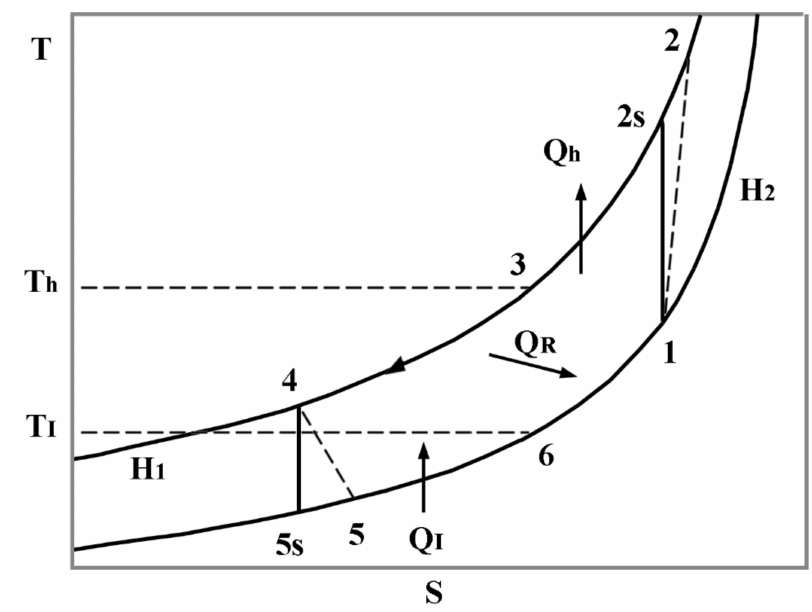
Figure 3. Brayton magnetic cycle with regeneration